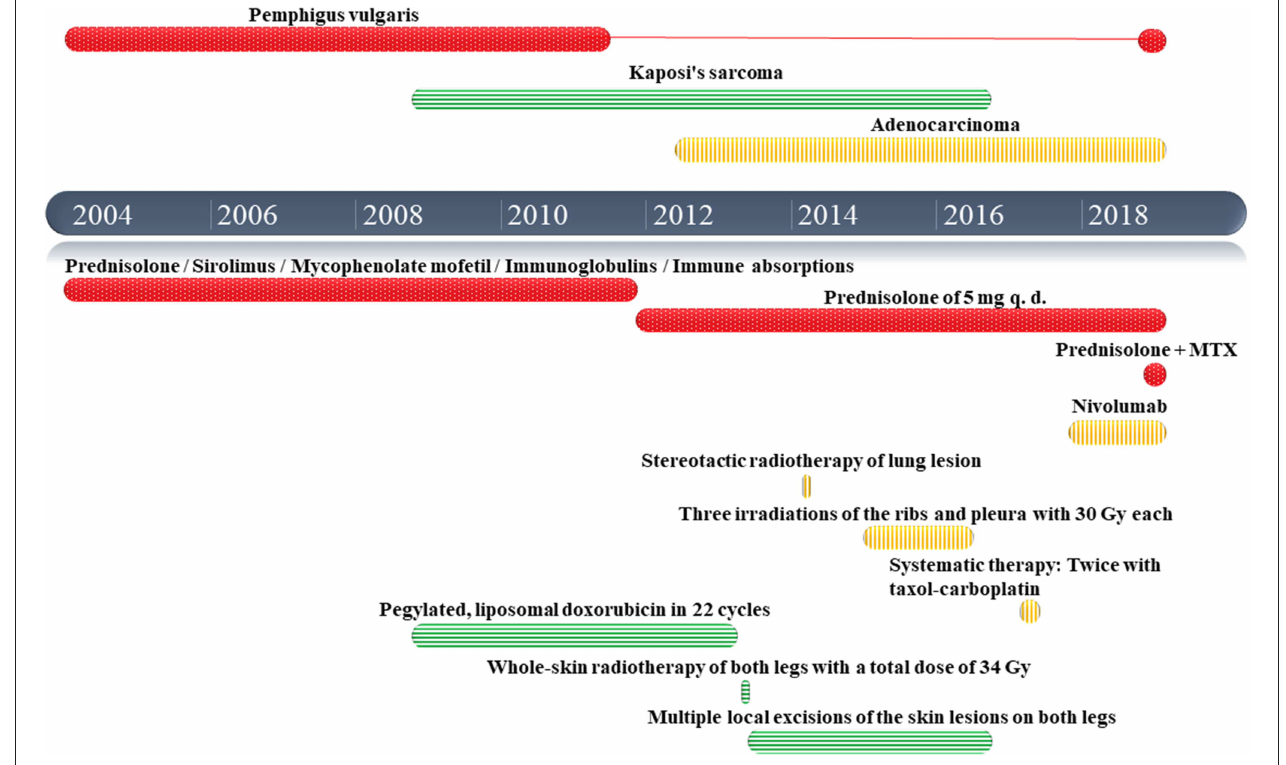
FIGURE 1 | Timeline of the patient’s diagnoses and treatments (in red information related to pemphigus vulgaris, in green information related to kaposi’s sarcoma and in yellow information related to the lung